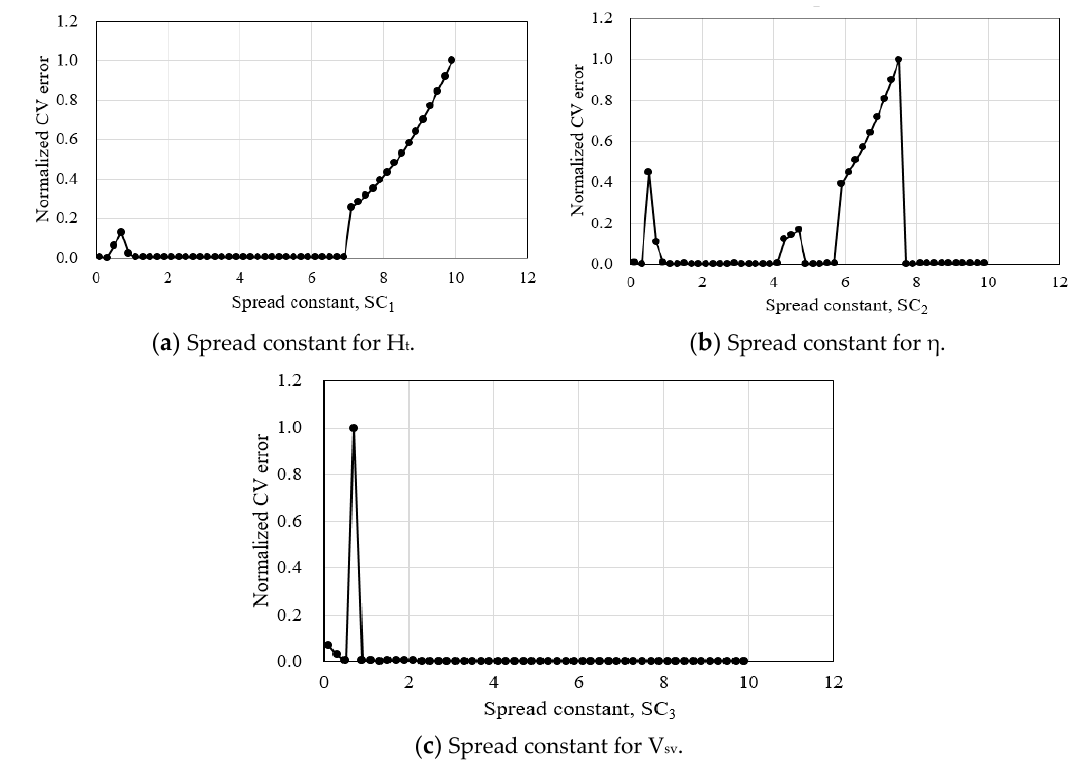
Figure 9. Cross-validation errors vs. spread constant (SC) values.